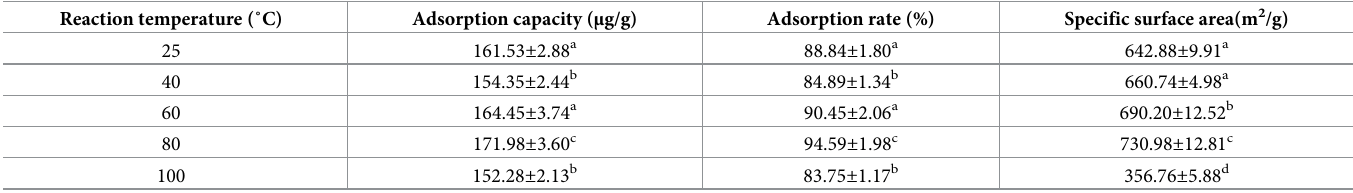
Table 4. Effect of reaction temperature on the specific surface area and adsorption to AFB1 of MMS.